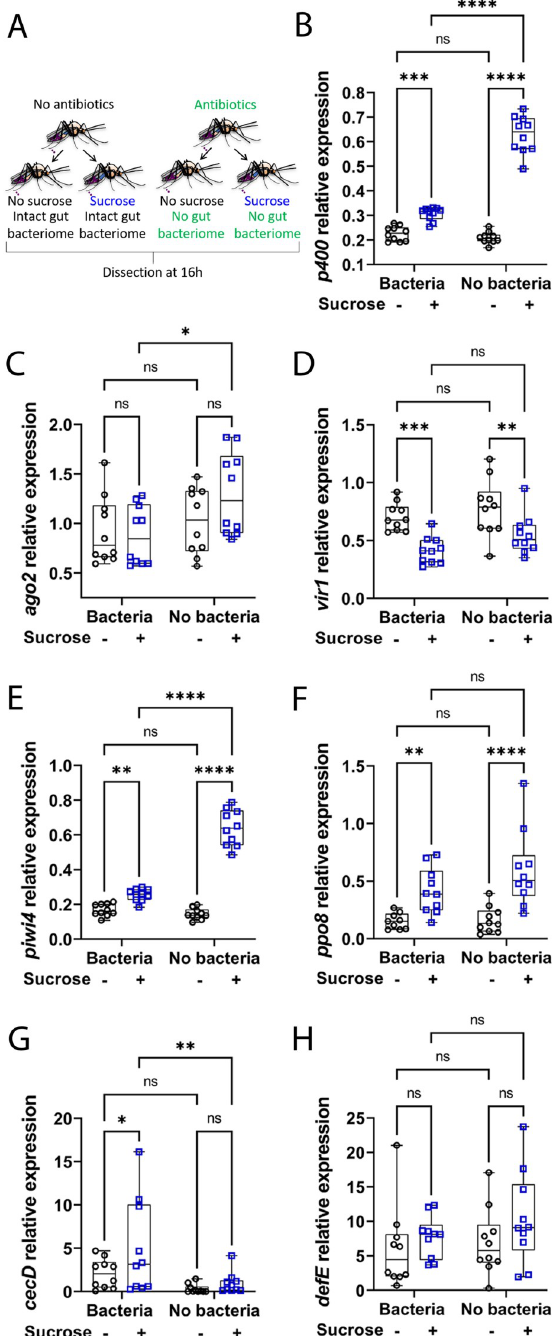
Fig 4. Microbiota partly inhibits sugar-induced immunity in the digestive tract of the female Ae . aegypti . (A) Schematic of experimental design. Females, previously treated or not with antibiotics, did not have access to sucrose for 48 h and were either not fed or fed with 10% sucrose. Digestive tracts were dissected 16 h post sugar feeding time. (B to H) RNA transcript levels of (B) p400 , (C) ago2 , (D) vir1 , (E) piwi4 , (F) ppo8 , (G) cecD and (H) defE . Box plots display the minimum, first quartile, median, third quartile, and maximum relative expression levels. Data from two separate experiments were combined after verifying the lack of a detectable experiment effect. N = 10 pools of 5 digestive tracts per condition. Statistical significance of the treatments effect was assessed with a two-way ANOVA (statistical analysis summary of treatment effect and interaction between treatments given in S4 Fig). Pair-wise comparisons shown on the graphs were obtained with a post hoc Fisher’s multiple comparison test (No sucrose